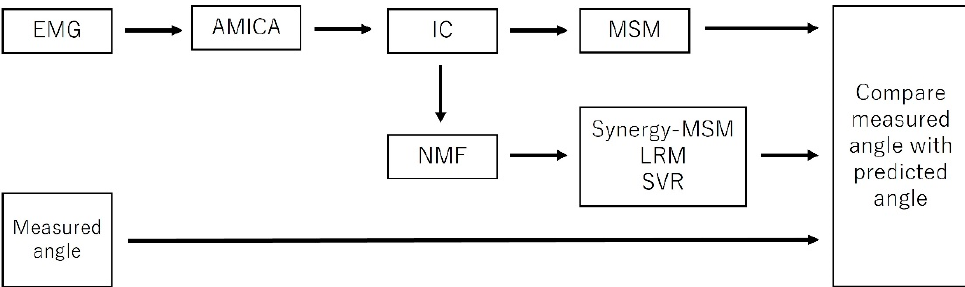
Figure 1. Process flow showing steps used in this study. The IC is calculated using AMICA, and the calculated IC is used to train the MSM. The muscle synergy calculated using IC is then used to train Synergy-MSM, LRM, and SVR, respectively. Finally, the measured angles are compared with the angles predicted by the model.